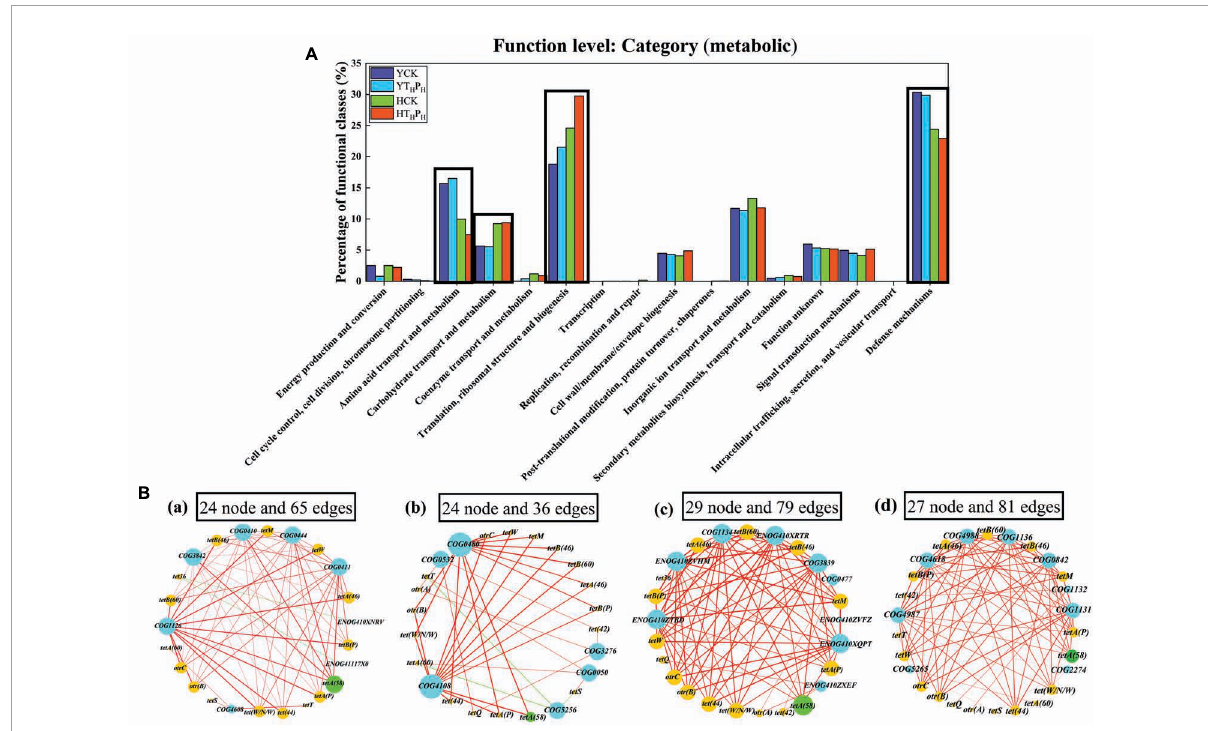
FIGURE8 Bacterial metabolic functional analysis. (A) Metabolic functional traits and categories of the four sediment samples according to the eggNOG database. (B) Correlation network analysis of TRGs and the predominant metabolic functional, (a) Correlation network analysis of TRGs and “Amino acid transport and metabolism,” (b) Correlation network analysis of TRGs and “Carbohydrate transport and metabolism,” (c) Correlation network analysis of TRGs and “Translation, ribosomal structure and biogenesis,” (d) Correlation network analysis of TRGs and “Defense mechanism.” The network graphs were displayed with Cytoscape 3.5.2 in Prefuse Force Directed Layout by betweenness centrality (correlation coefficient >